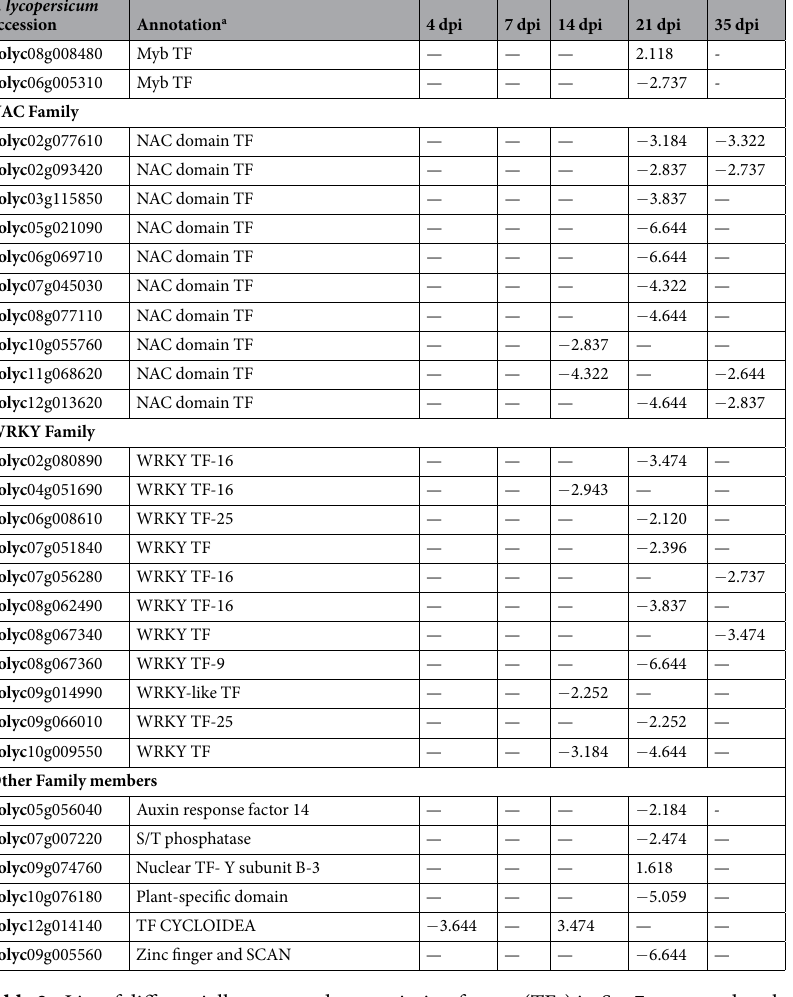
Table 2. List of differentially expressed transcription factors (TFs) in Sw-7 compared to the S-line after TSWV inoculation. a TF-Transcription Factor; S/T-Serine threonine; ZF-Zinc